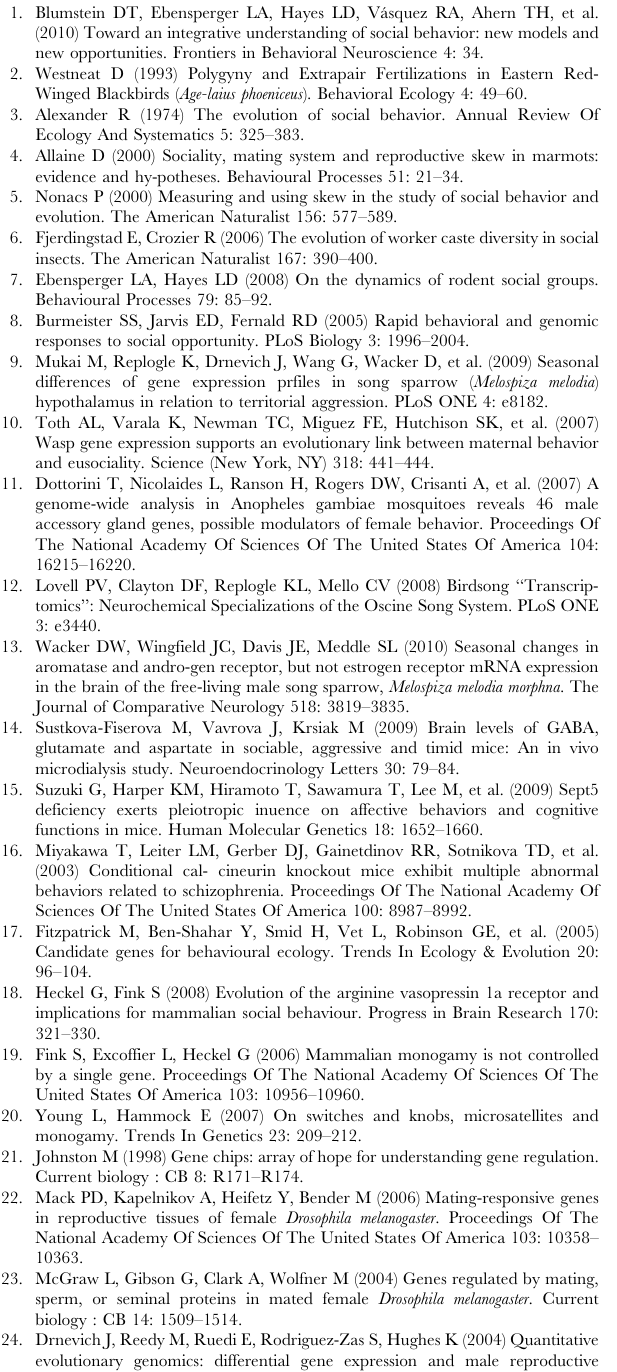
Table S3 A list of all GO terms grouped by molecular function. Column 1 is the GO ID, followed by the GO term description, followed by the number of sequences assigned to this term in column